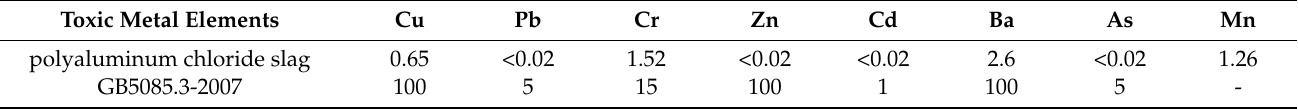
Table 2. Mass concentration of heavy metal leaching from polyaluminum chloride residue (mg/L). Toxic Metal